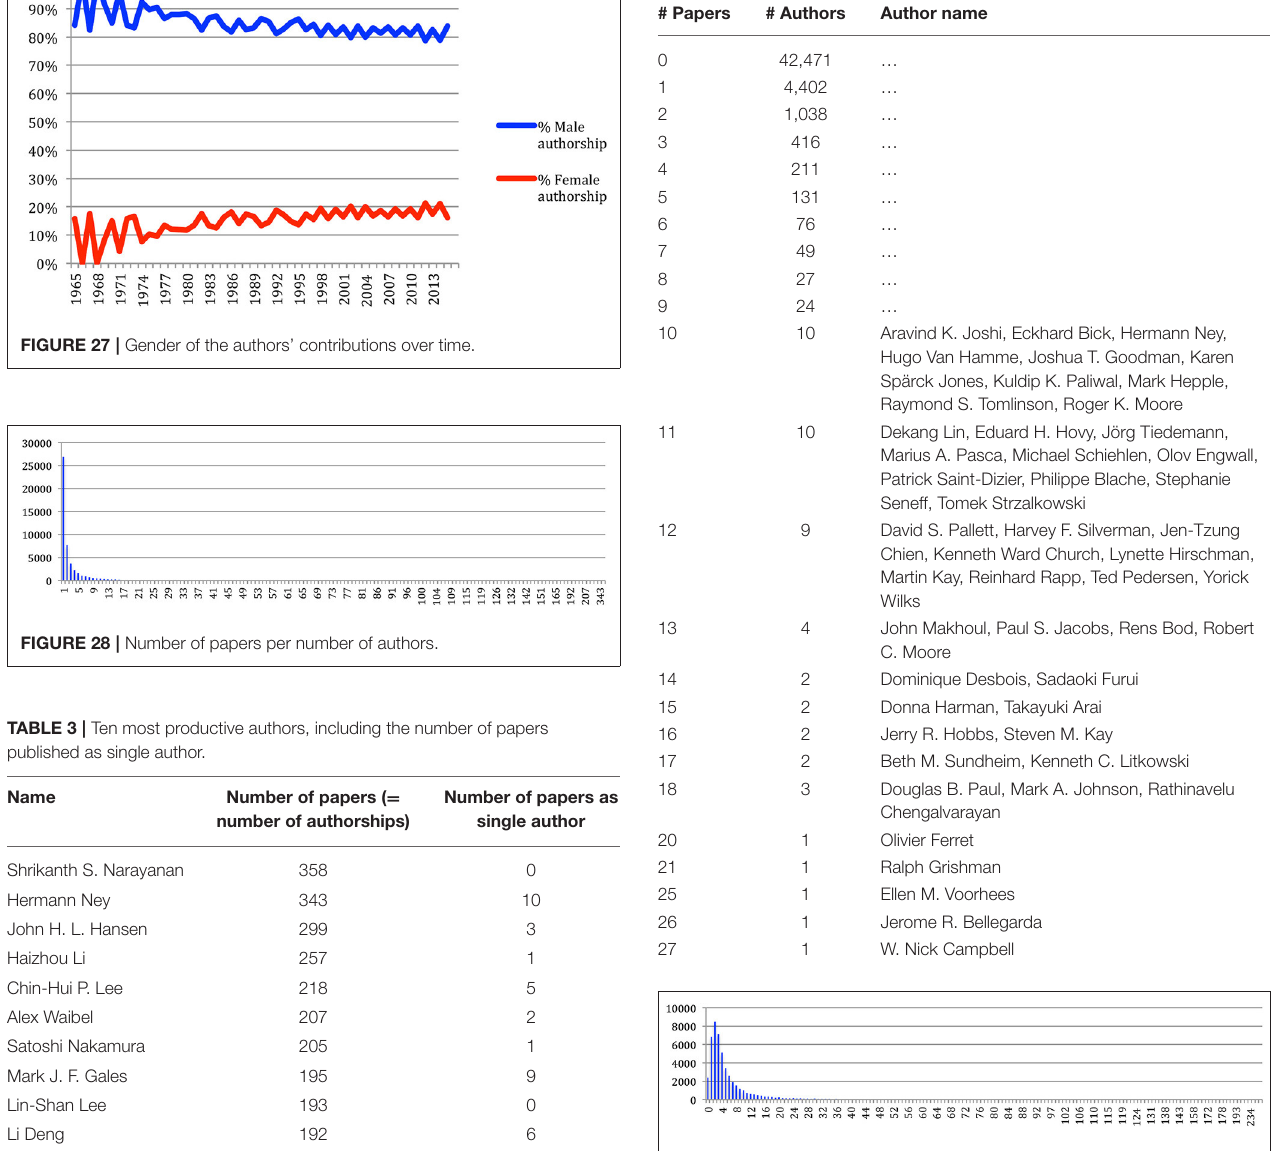
FIGURE 29 | Number of authors as a function of the number of different co-authors.